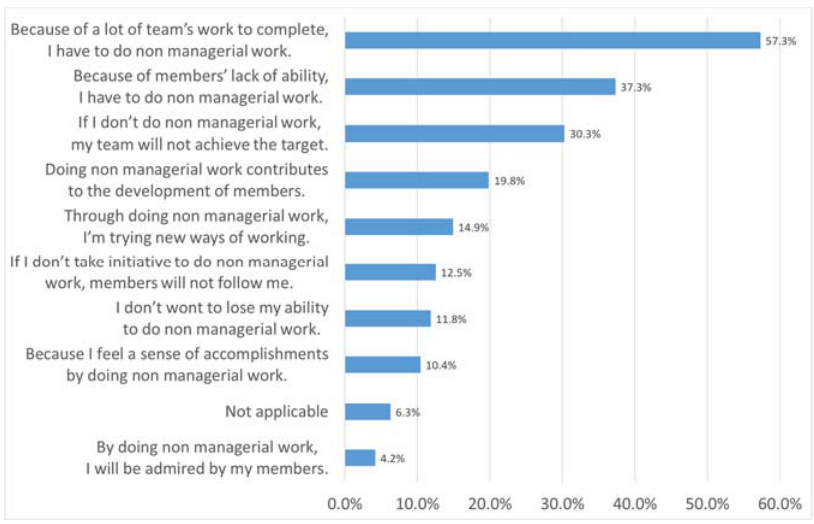
Figure 2. Reasons for non-managerial